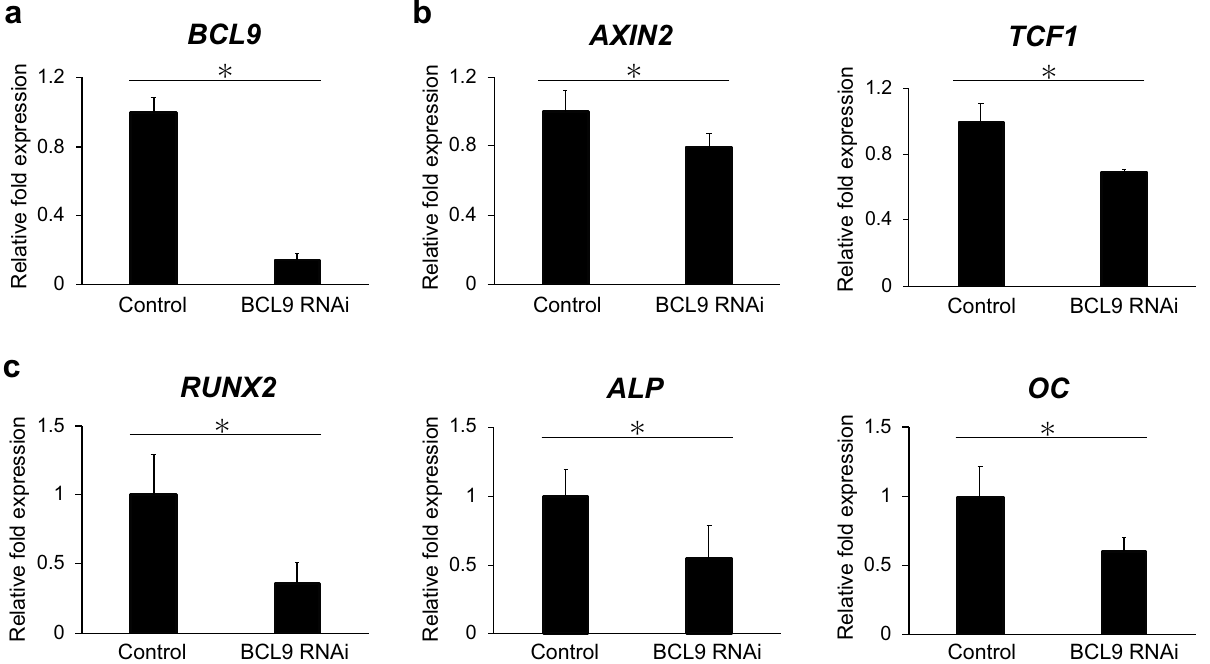
Figure 5. BCL9 RNAi suppresses osteo/odontoblast differentiation and Wnt/β-catenin signaling. BCL9 RNAi downregulates the mRNA expression of BCL9 ( a ), Wnt/β-catenin target genes (AXIN2 and TCF1) ( b ), and osteo/odontoblast differentiation markers (RUNX2, ALP, and OC) ( c ) in hypoxic culture (1% O 2 ) for 48 h. Error bars indicate standard deviation (n = 4). *p <